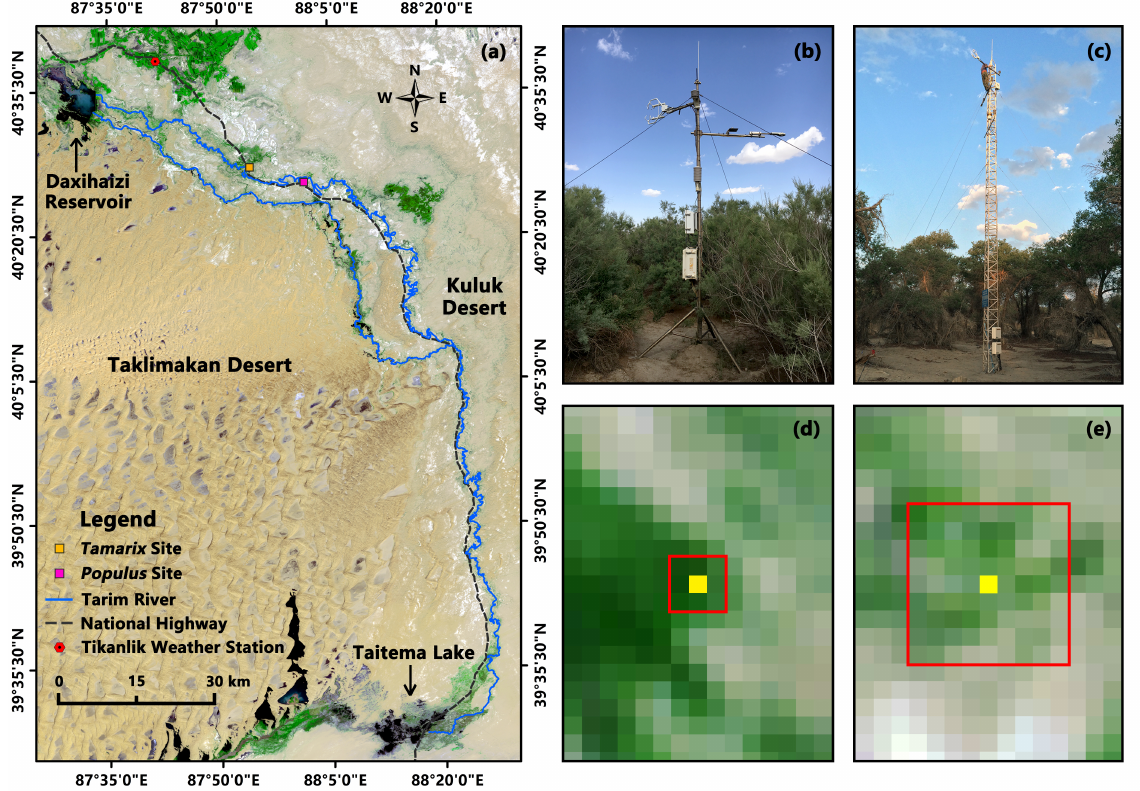
Figure 1. Locations of the two study sites ( a ); photos of the Tamarix site ( b ) and the Populus site ( c ); locations of the flux tower and its appropriate footprint area for the Tamarix site ( d ) and the Populus site ( e ) shown with a Landsat image. The yellow squares in ( d , e ) represent the pixels where the flux tower of the Tamarix site and the flux tower of the Populus site located, respectively. The red boxes in ( d , e ) denote the appropriate footprint area measured by the flux tower of the Tamarix site and by the flux tower of the Populus site,